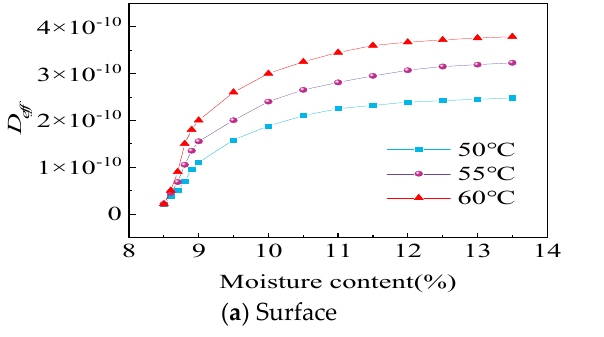
ln D eff and 1/ T were used for plotting, and a line was obtained by fitting, as shown in Figure 13. The activation energies of the tobacco strips’ surface and middle were 37.86 kJ/mol and 37.15 kJ/mol, respectively. The activation energy of the surface was slightly higher than that of the interior, which indicated that the effective moisture diffusiv- ity increased faster on the surface than in the interior at the same temperature.